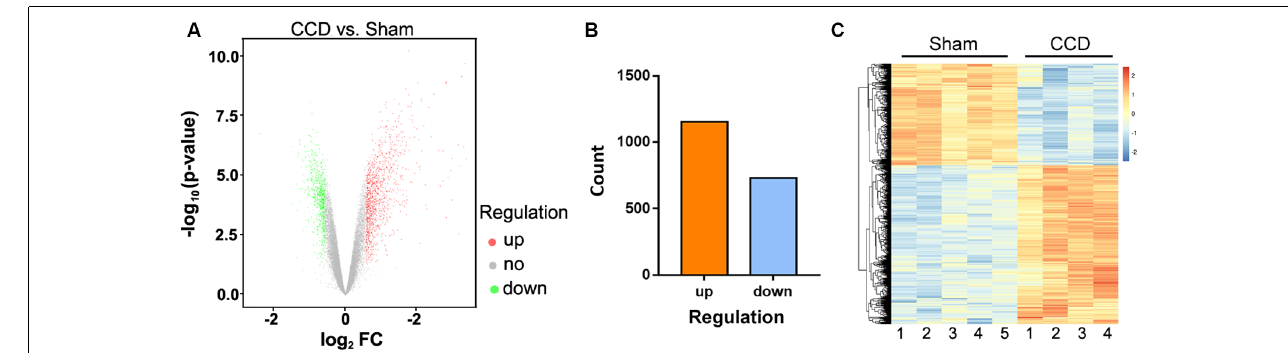
FIGURE 2 | DEGs between the CCD group and the sham group. (A) Volcano plot of the − log 10 ( p -value) against the log 2 FC of each gene. Red dot indicates an upregulated DEG, whereas green dot indicates a downregulated gene. Gray indicates that there is no statistically significant difference in gene expression. (B) There were 1,887 DEGs identified between the CCD group and the sham group. Of these genes, 1,156 were upregulated and 731 were downregulated. (C) Hierarchical clustering shows the DEGs between the two groups. The number at the bottom represents the name of the samples. The color scale at the top right represents the normalized expression data, which represents the degree of gene clustering. The upregulated genes are indicated in red, and the downregulated genes are indicated in blue. DEGs, differentially expressed genes; CCD, chronic compression of the dorsal root ganglion surgery group; FC, fold change; sham, compression of the dorsal root ganglion sham group. The p -value was corrected by false discovery rate